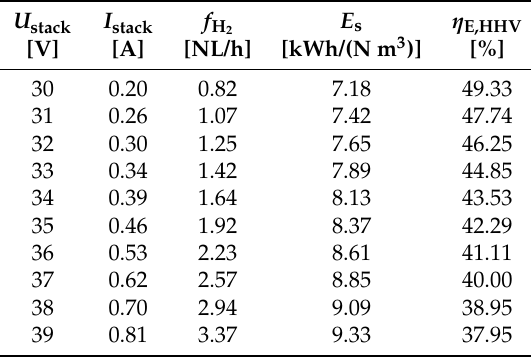
Figure 5. Main energy efficiency parameters of the electrolyzer stack. Table 1. Main energy efficiency parameters of the electrolyzer stack calculated based on the measured stack voltage and